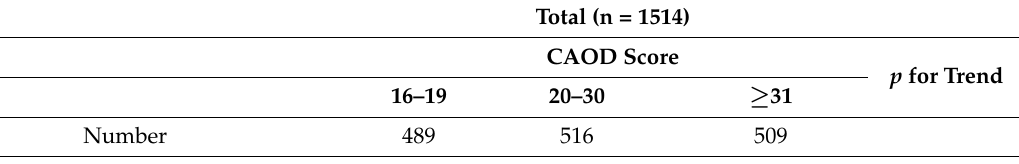
Table 2. Multivariable-adjusted odds ratios and 95% confidence intervals for metabolic syndrome and each of its component factors according to CAOD score categories in all participants and stratified by overweight status and age